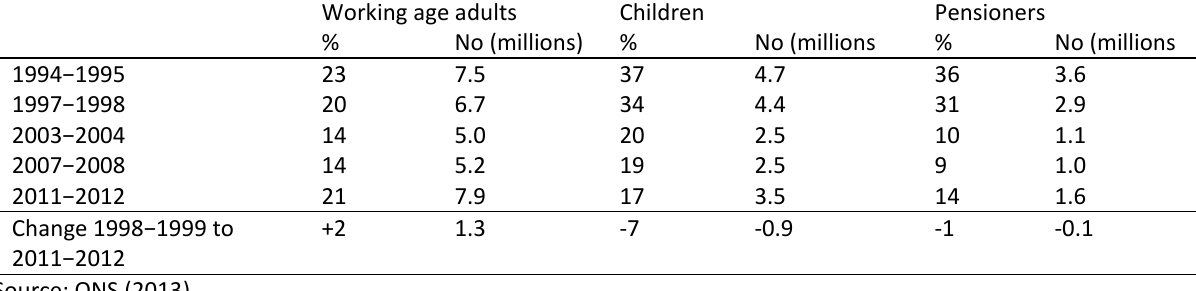
Table 1. Poor children, adults, and pensioners, 1994−1995 to 2011−2012 (% and “relative income”, number below 0.6 median after housing costs, in real